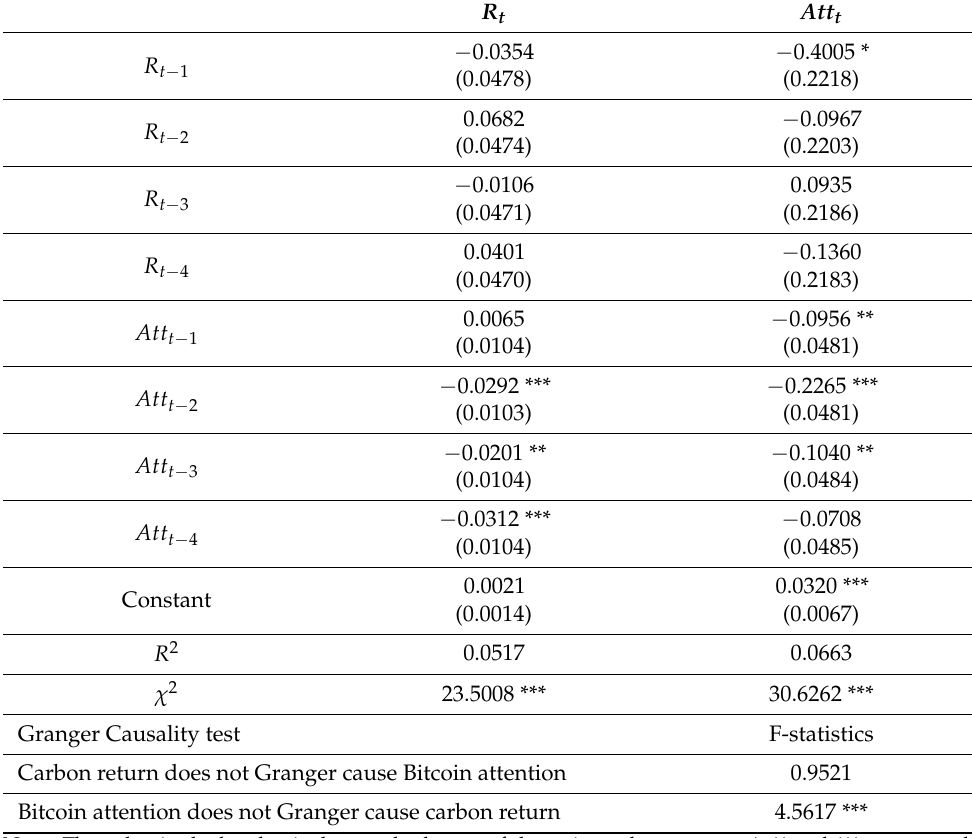
Table 3. VAR estimation and Granger causality